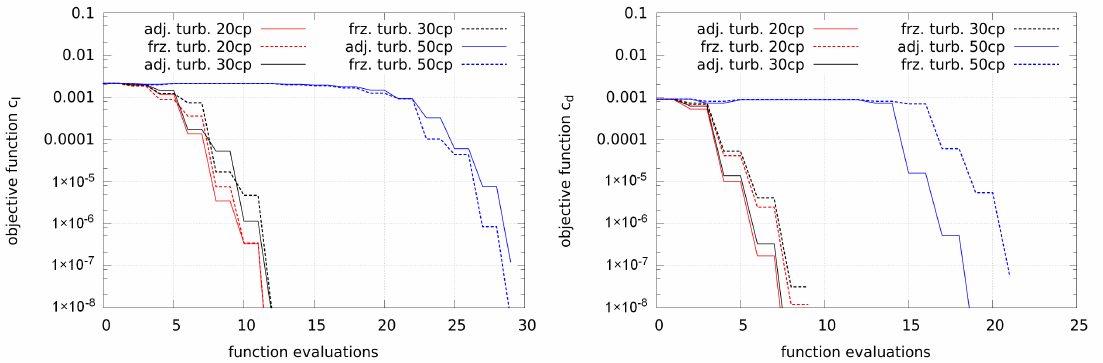
Figure 14. Objective functions for lift and drag as in Equation (14) along the number of function evaluations for the DU 93-W-210 at AoA = 2 ◦ . Frozen as well as adjoint turbulence is used. The number of control points is labeled as